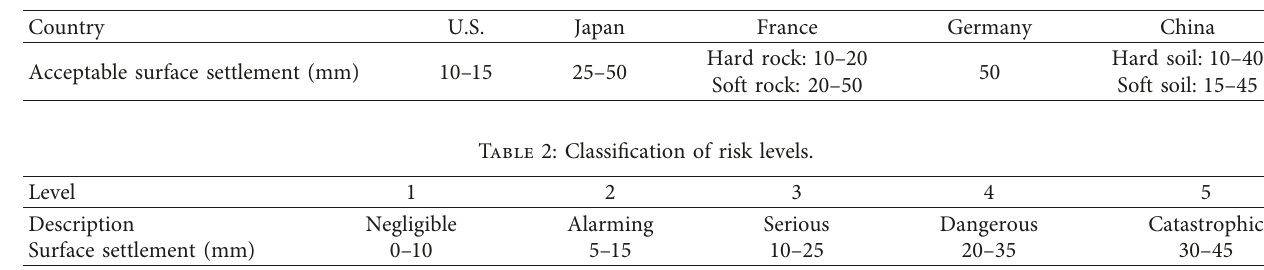
Figure 1: Location of XWS in the Wuhan metro Table 1: Standards for monitoring surface settlement in shield tunnel excavation.